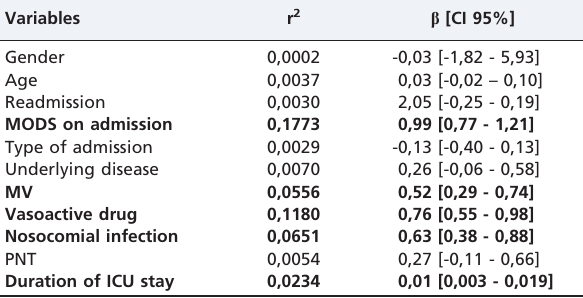
Table 4 – Univariate linear regression of the association between risk factors and the